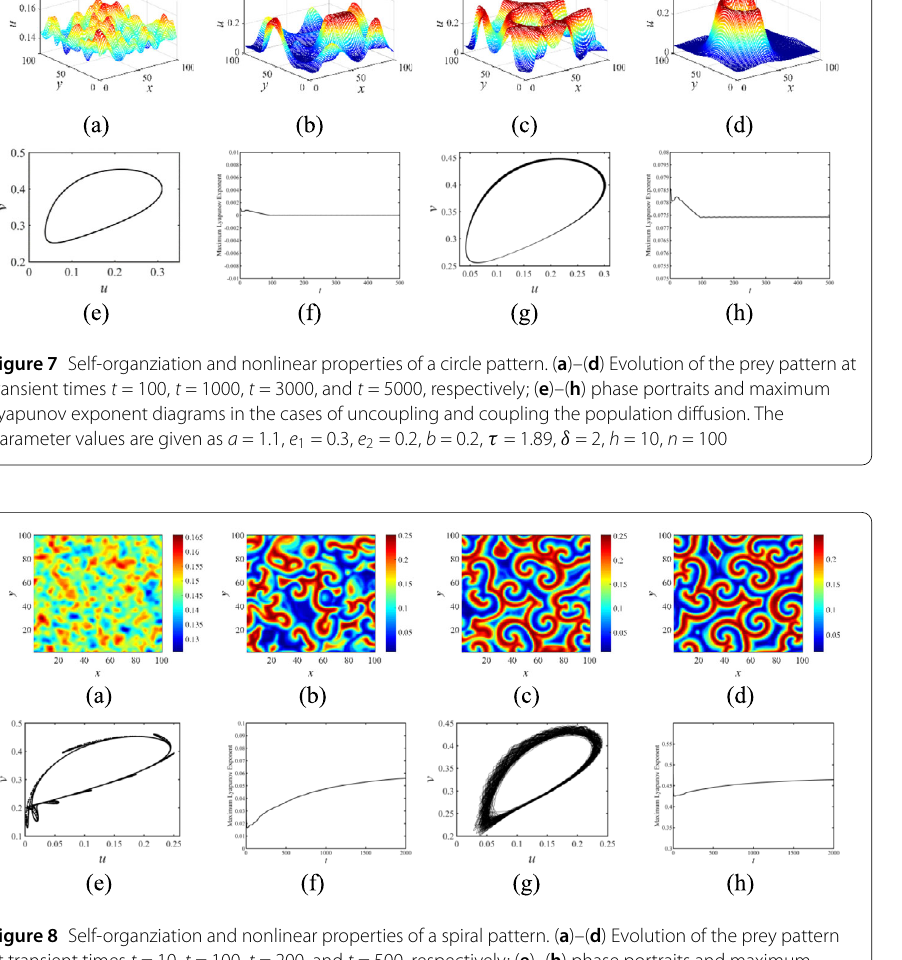
the gradual increase of time, a part of the spot and stripe patches in the pattern will dis- appear but some of them will combine together to form a circle (Fig. 7d). Comparing with the phase portraits and maximum Lyapunov exponent diagrams without and with consid- eration of the spatial diffusion (Fig. 7e–h), we find that the circle pattern is self-organized through the spatial symmetry breaking on a closed invariant curve. The pattern forma- tion results to a transition from quasiperiodic behavior to chaotic behavior in the discrete predator–prey system. The self-organization of spiral pattern demonstrated in Fig. 8 is also induced by the Neimark–Sacker–Turing instability. Different from Fig. 7, this pattern emerges through spatial symmetry breaking on a state which is homogeneous in space and chaotic in time. As described in Fig. 8e–8h, the complexification of phase portrait and in- crease of maximum Lyapunov exponent imply that the pattern formation strengthens the chaotic state along the temporal scale. However, the distribution of the prey population still presents high degree of order in space. Such a result suggests that spatial order can generate from temporal disorder via the mechanism of Turing pattern